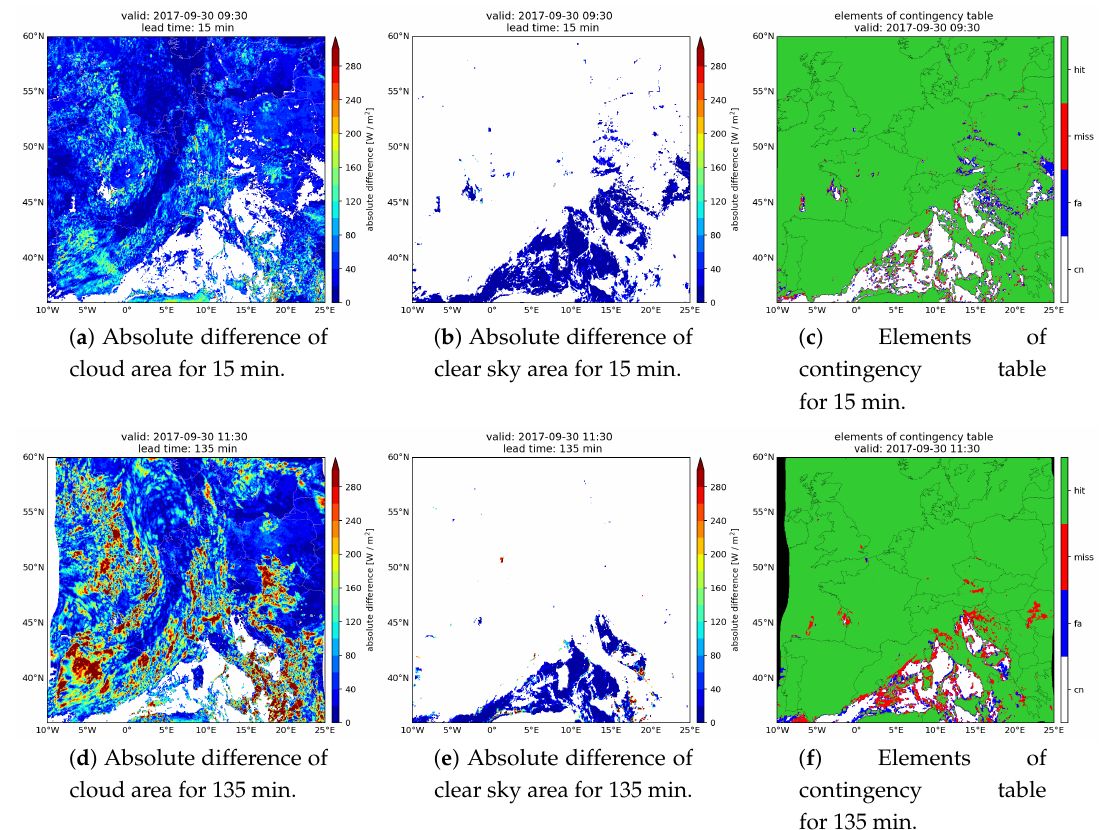
Figure 6. Results of the validation for 30 September 2017 with SARAH-2 and an additional cloud mask. Depicted are the absolute difference between the nowcasting and the SARAH-2 data ( a , b , d , e ), as well as a map of the elements of the contingency table ( c , f ). These results are shown for 15 (upper) and 135 min (lower),